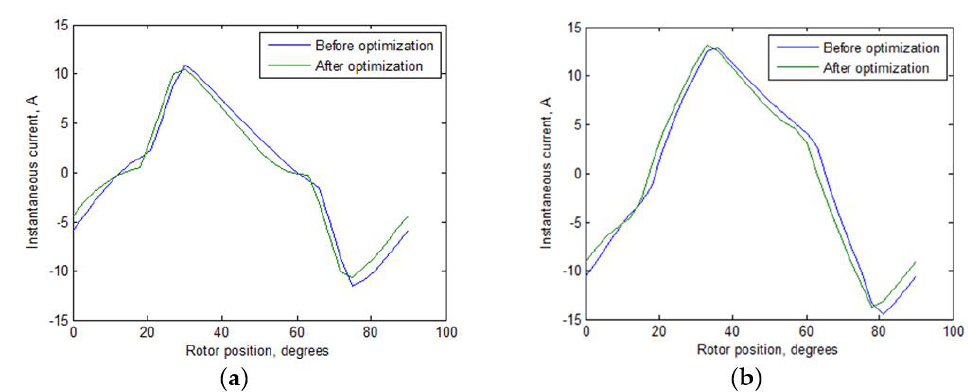
Figure 5. Current dependencies on the rotor position before and after the optimization: ( a ) mode 1; ( b ) mode 2.